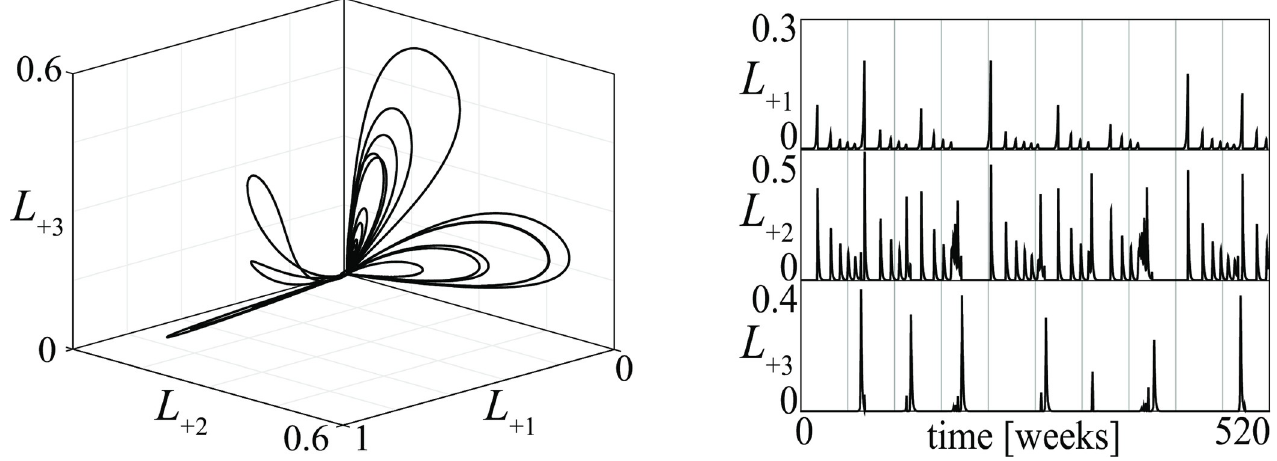
Fig 16. Stalemate of the same conflict described in Fig 14 but with an increased reactiveness ρ 1 of the D group (from ρ 1 = 0.05 to ρ 1 = 0.5).